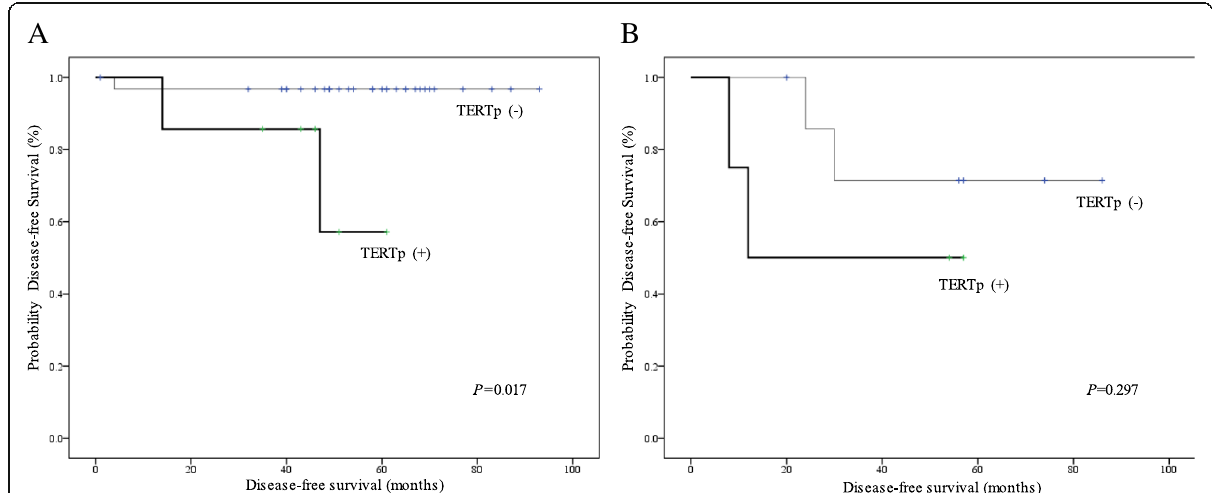
Fig. 3 Kaplan-Meier curves of disease-free survival by TERTp mutational status in patients with FTC. Results from the analysis of patients with ( a ) minimally invasive /encapsulated angioinvasive histologic type and ( b ) widely invasive histologic